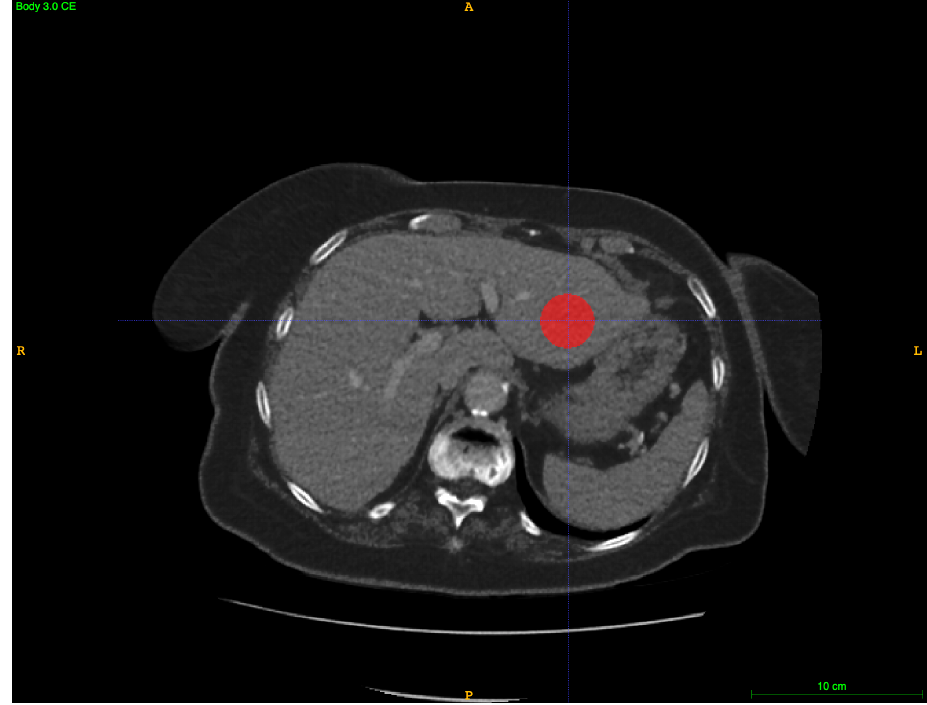
Figure 1. Spherical region of interest (ROIs) in portal venous healthy liver tissue (axial plane) using ITK-snap.